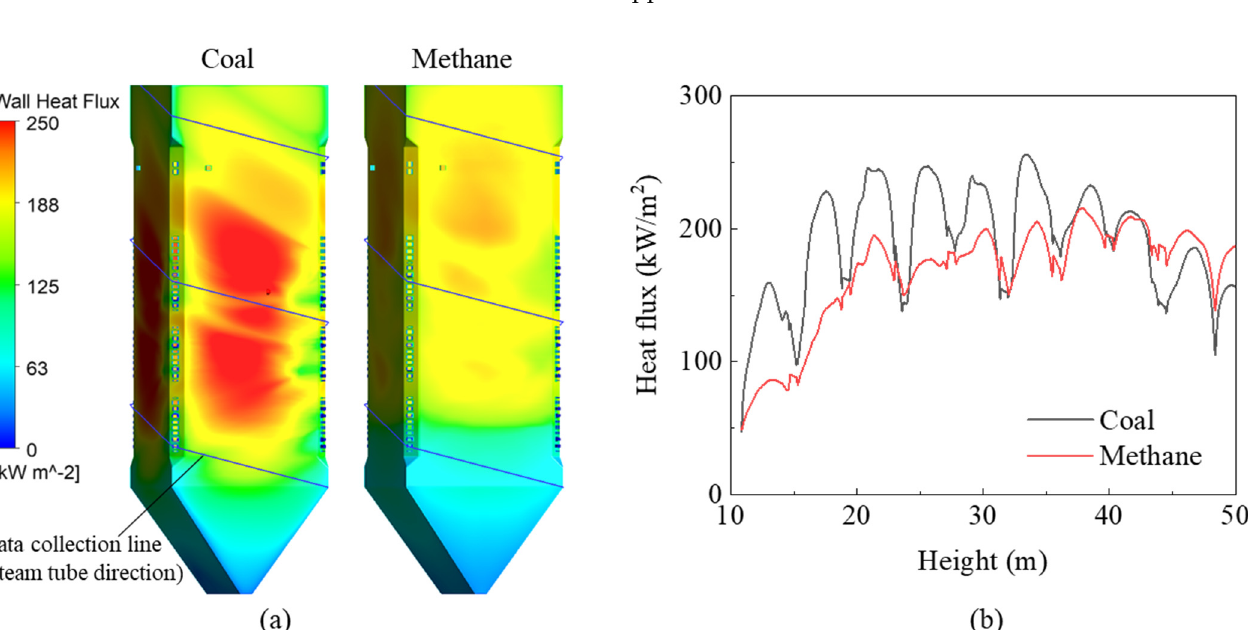
Figure 8. Changes in heat absorption by conversion to methane.